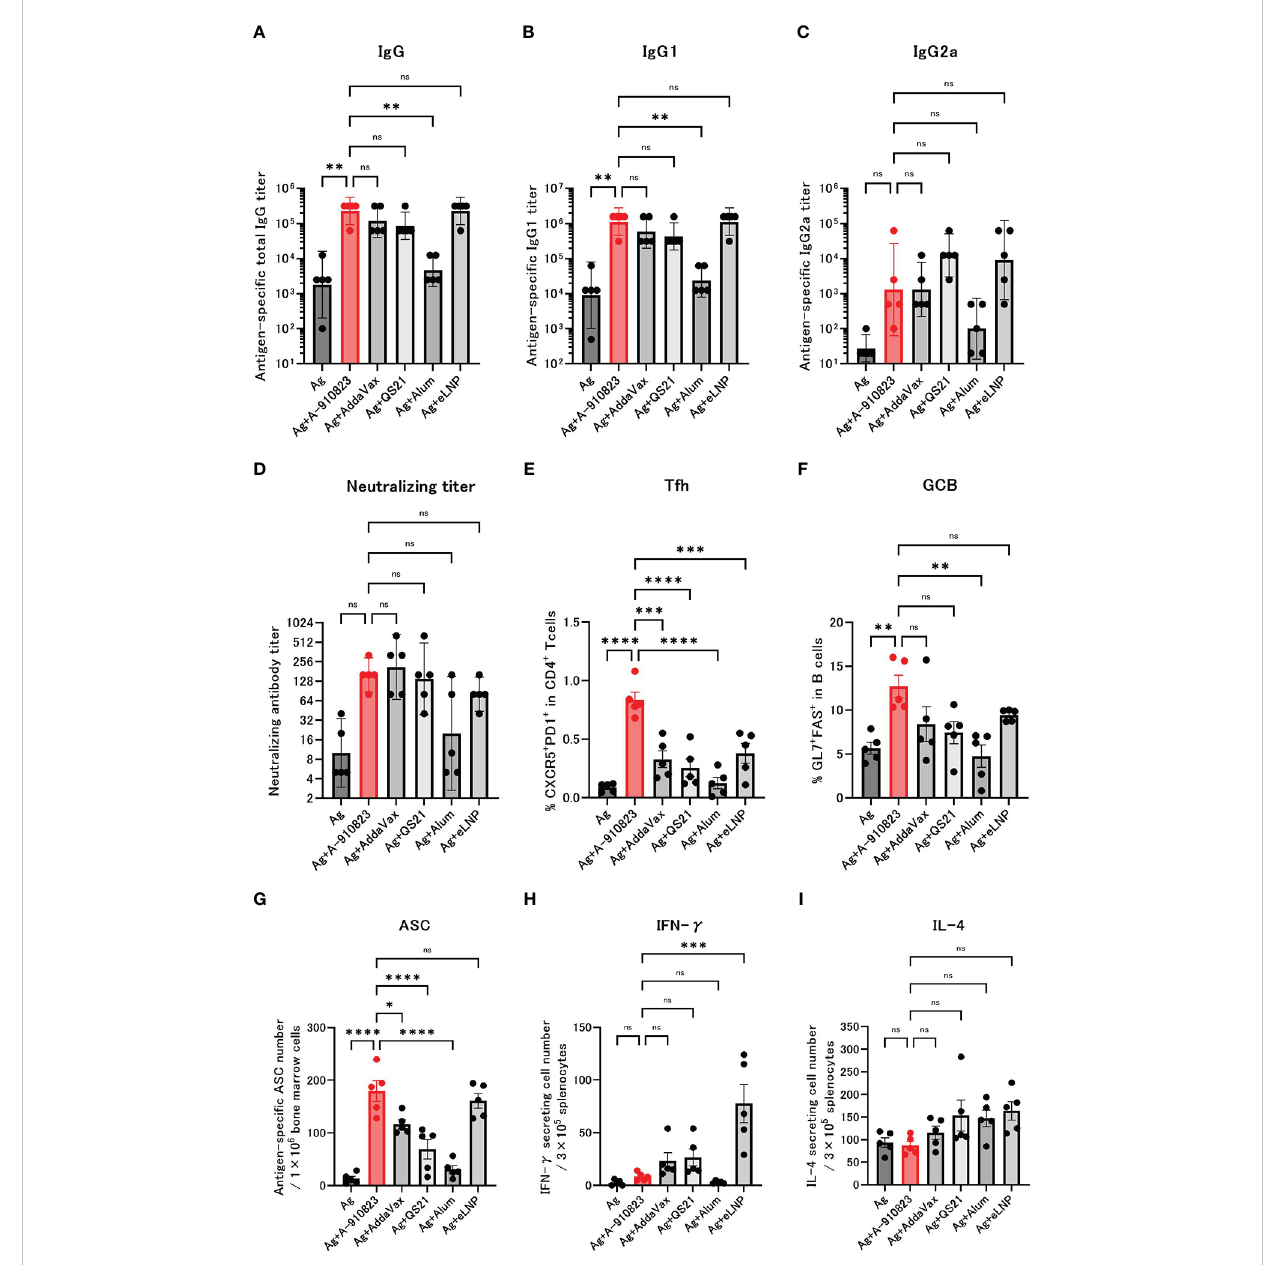
FIGURE 1 A-910823 induces robust Tfh cells and humoral immune responses. Balb/c mice were injected IM with SARS-CoV-2 S-protein S-910823 (Ag) alone or Ag mixed with each adjuvant on days 0 and 14 (n=5/group). (A – C) Antigen-speci fi c total IgG, IgG1, and IgG2a titers in the sera on day 28. Each bar represents the GMT; error bars indicate the 95% con fi dence interval. Each circle represents the titer in individual mice. (D) Serum titers of neutralizing antibodies against SARS-CoV-2 on day 28. Each bar represents the GMT; error bars indicate the 95% con fi dence interval. Each circle represents the neutralizing antibody titer in individual mice. (E) Percentages of Tfh (PD1+CXCR5+) cells in TCRb+CD4+ cells and (F) percentages of GCB (FAS+GL7+) cells in CD19+ cells in the draining lymph nodes on day 28. Each bar represents the mean; error bars indicate the standard error of the mean. Each circle represents the percentages of Tfh and GCB cells in individual mice. (G) The number of ASCs in bone marrow on day 109 was determined by ELISpot. Each bar represents the mean; error bars indicate the standard error of the mean. Each circle represents the antigen-speci fi c spot-forming cells in individual mice. (H – I) The number of cytokine-secreting cells in the spleen of immunized mice on day 28 was determined by ELISpot. Each bar represents the mean number of antigen-speci fi c spot-forming cells; error bars indicate the standard error of the mean. Each circle represents the antigen-speci fi c spot-forming cells in individual mice. Statistical signi fi cance was determined using Tukey ’ s multiple comparison test (ns, P ≥ 0.05, *P<0.05, **P<0.01, ***P<0.001, and